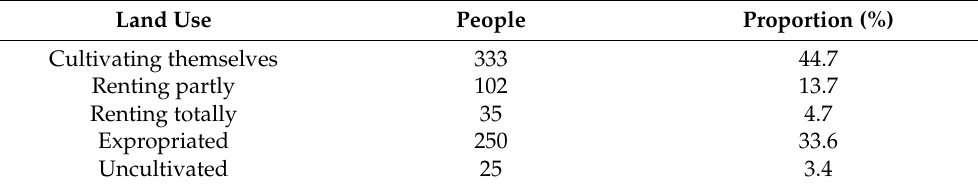
Table 4. Land use by elderly people in rural villages.